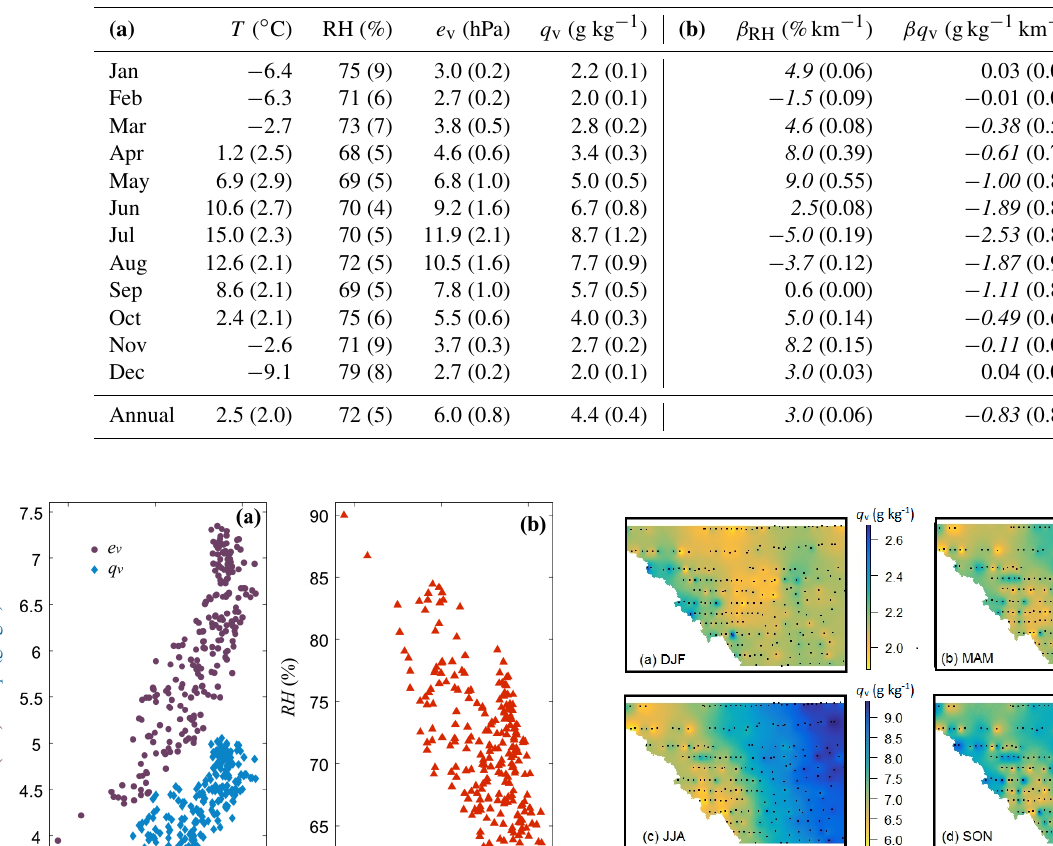
Table 2. (a) Monthly means (and standard deviations) of temperature, relative humidity, vapour pressure, and specific humidity across all FCA sites. Standard deviation refers to the spatial variability in mean monthly values. (b) Mean monthly lapse rates of relative and specific humidity, based on a linear regression with elevation: β RH = dRH / d z and βq v = d q v / d z . R 2 values from the linear regressions are given in brackets. Italicized values are statistically significant ( p < 0 . 01).